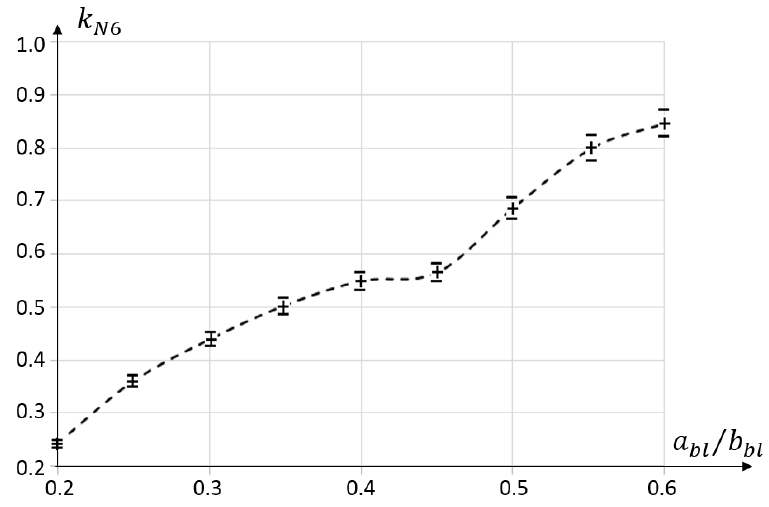
Figure 16. Influence of the parameter 𝑎 (cid:3029)(cid:3039) /𝑏 (cid:3029)(cid:3039) on the power factor 𝑘 (cid:3015)(cid:2874) (experimental data). The dependence shows that the maximum value of 𝐾 (cid:3030)(cid:3035)(cid:3040) was achieved at 𝑎 (cid:3029)(cid:3039) /𝑏 (cid:3029)(cid:3039) from 0.35 to 0.45. Therefore, in the specified range of 𝑎 (cid:3029)(cid:3039) /𝑏 (cid:3029)(cid:3039) , the maximum intensity of mixing of the mixture was achieved. The mixture moved from laminar to turbulent regime. The rate of mass transfer of the foam concrete mixture in the axial direction increased. Moreover, an increase in the parameter 𝑎 (cid:3029)(cid:3039) /𝑏 (cid:3029)(cid:3039) led to an increase in power consumption. In the 𝑎 (cid:3029)(cid:3039) /𝑏 (cid:3029)(cid:3039) range of 0.35–0.45, some stabilization of 𝑘 (cid:3015)(cid:2874) was